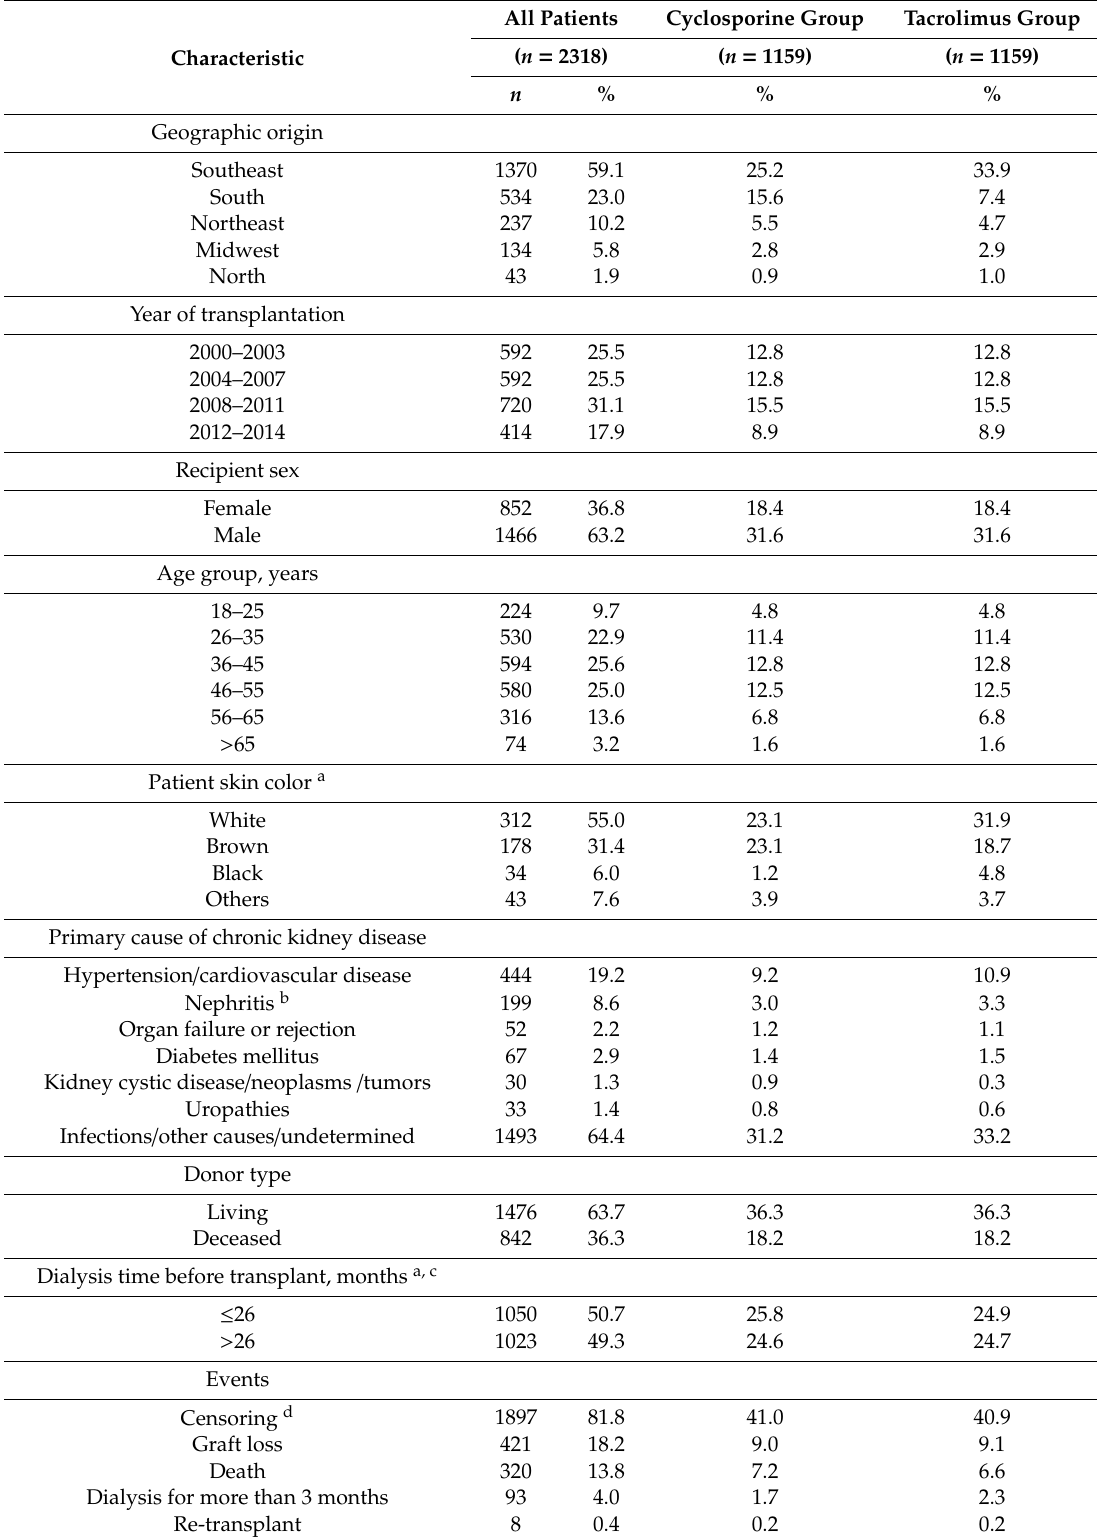
Table 1. Demographic characteristics of study patients (Brazil, 2000–2015; n = 2318). All Characteristic